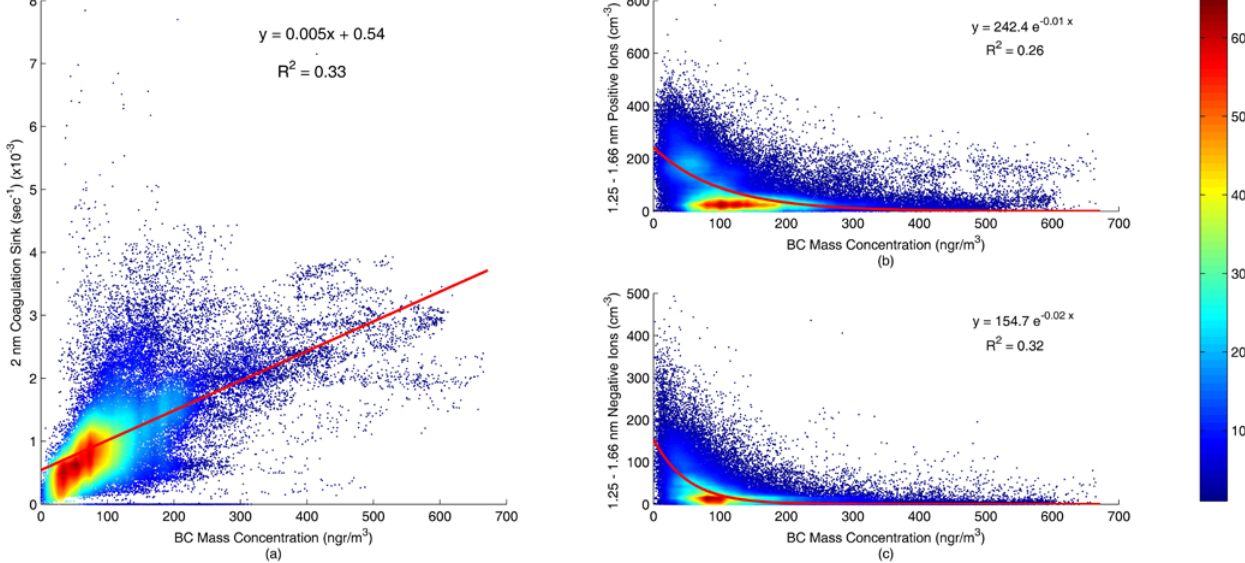
Fig. 7. 2nm Coagulation Sink variability versus BC mass concentration (a) and variability of atmospheric cluster concentrations at the size range 1.25–1.66nm depending on BC mass concentration for positive (b) and negative charges (c) , respectively.